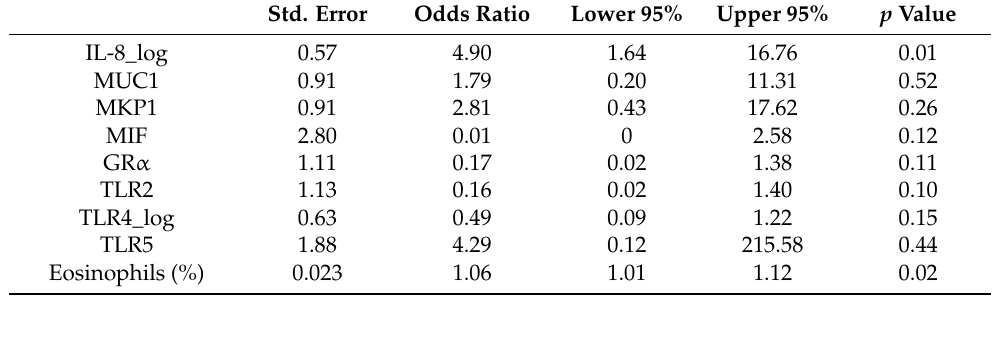
Table 3. Association between SNOT-22 and molecular parameters. IL-8 interleukin 8, MUC1 mucin 1, MKP1 mitogen-activated protein kinase phosphatase 1, MIF macrophage migration inhibitory factor, GR α Glucocorticoid receptor α , TLR2 toll-like receptor 2, TLR4 toll-like receptor 4, TLR5 toll- like receptor 5.